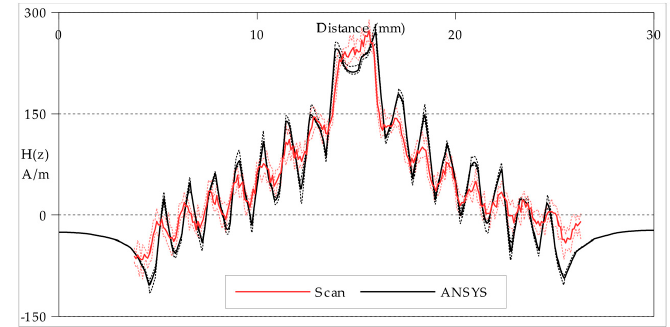
Figure 9. H ( z ) amplitude plots of the Square planar coil along the path indicated by red single-chevrons in Figure 7 at a scan height of 0.15 mm ± 0.01 mm. The ± errors are indicated by dashed lines above and below for both the Scan and ANSYS plots. The distance scale is the distance (mm) along the path from the left edge of the planar coil.